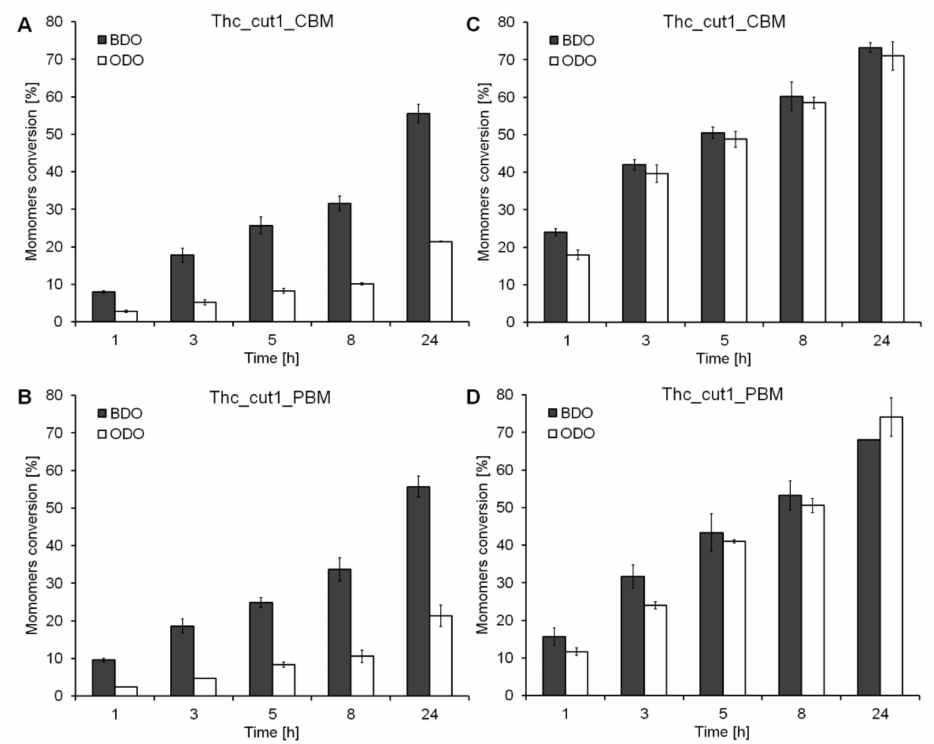
Figure 3. Enzymatic polycondensations of DMA and BDO or ODO catalyzed at 70 ◦ C ( A , B ) or 50 ◦ C ( C , D ) using two different cutinases fused with binding domains (Thc_Cut1_CBM, Thc_Cut1_PBM).